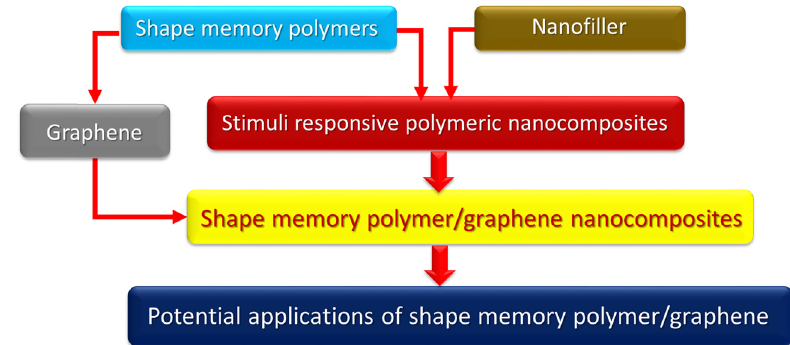
Figure 1: Schematic of the overview of shape memory polymer/graphene